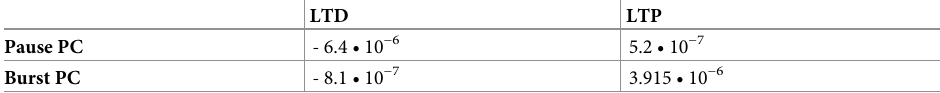
direction of PF-PC synaptic weight